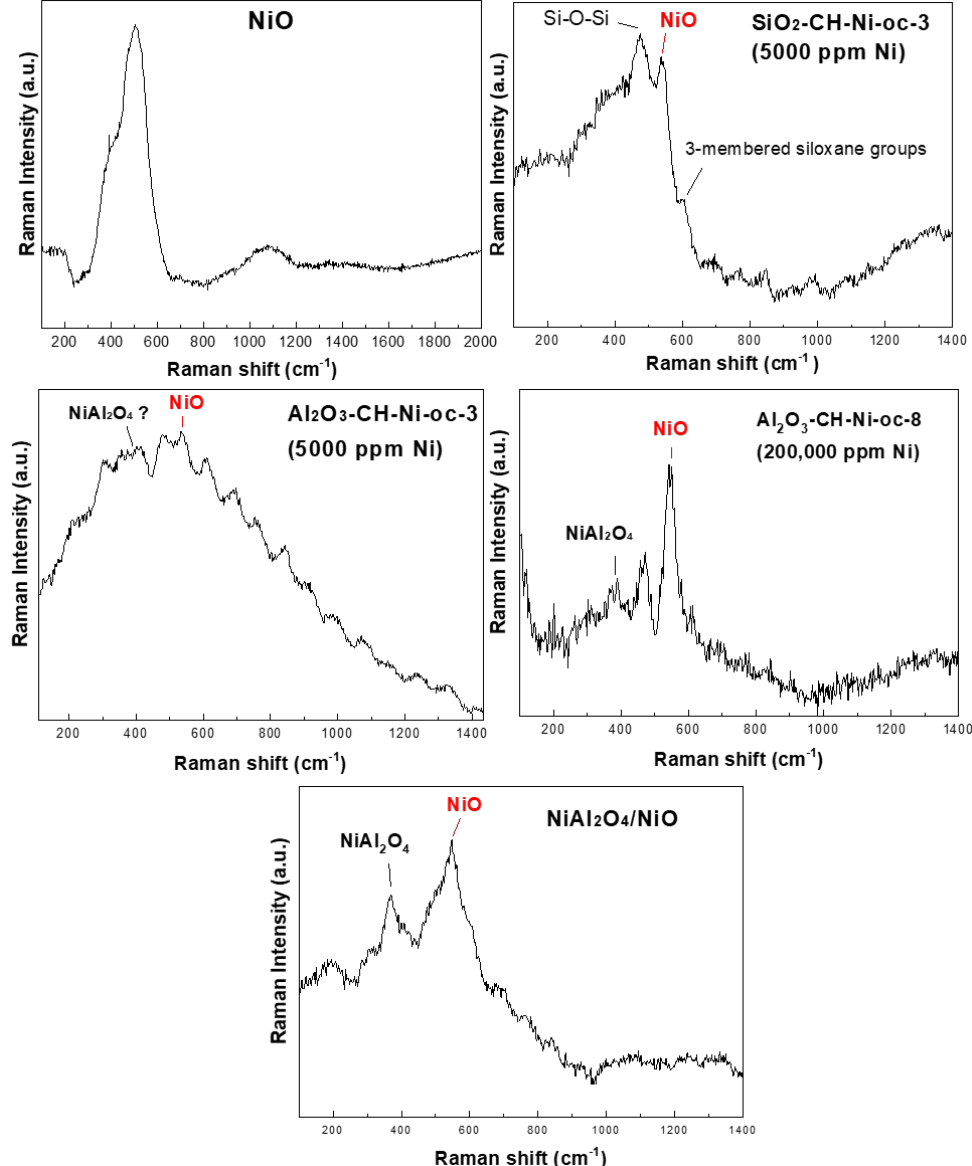
Figure 12. Raman spectra of bulk NiO and NiAl 2 O 4 /NiO and of representative Ni-impregnated SiO 2 and Al 2 O 3 materials: SiO 2 -CH-Ni-oc-3 (5000 ppm Ni), Al 2 O 3 -CH-Ni-oc-3 (5000 ppm Ni) and Al 2 O 3 -CH-Ni-oc-8 (200,000 ppm Ni).